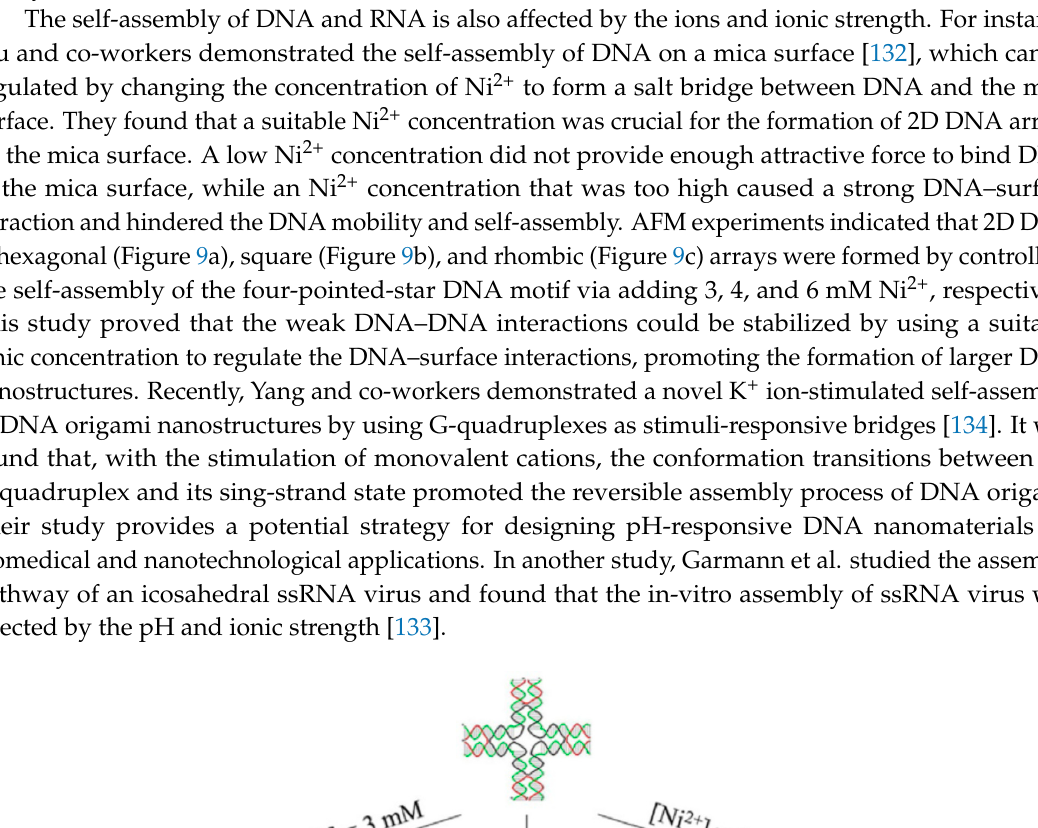
Figure 10. Effects of organic solvents on biomolecular self-assembly: ( a ) The structural transition of FF nanofibers in mixed organic solvents. Reprinted with permission from [136]. Copyright 2010 WILEY-VCH. ( b ) Vertically well-aligned peptide nanowires prepared by high-temperature aniline vapor aging. Reprinted with permission from [140]. Copyright 2008 WILEY-VCH. ( c ) A phase transition induced by trace amounts of organic solvent. Reprinted with permission from [142]. Copyright 2016 American Chemical Society. ( d ) Kinetic mechanisms of peptide self-assembly studied by molecular dynamics simulation (MDS). Reprinted with permission from [143]. Copyright 2015 American Chemical Society.